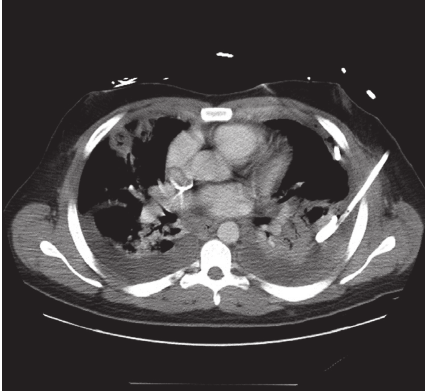
Figure 2: Horizontal section of chest computed tomography (CT) with contrast showing left-sided, multiloculated pleural effusion, status postplacement of pigtail catheter. Multifocal areas of nec- rotizing pneumonia and multiple pulmonary abscesses with smaller right-sided pleural effusion are also